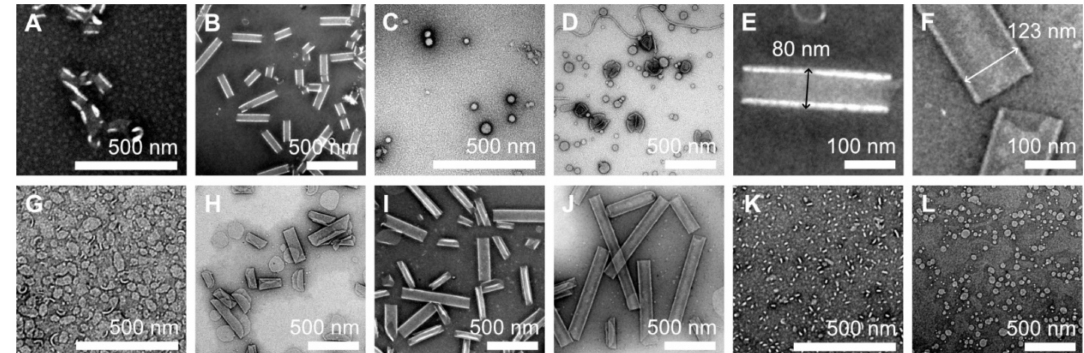
Figure 3. Negatively stained TEM images (samarium acetate stain) of peptide assemblies prepared from SL12 ( A , B , E ), SL4A4L4 ( C , D ), SA2L12A2 ( F – J ), and SL16 ( K , L ) after heat treatment at 90 ◦ C for 0 h ( A , C , G , K ), 1 h ( B , D , H , L ), 3 h ( I ), and 6 h ( J ). ( E , F ) are the magnifications of ( B , J ). Scale bars are 500 nm ( A – D , G – L ) and 100 nm ( E , F